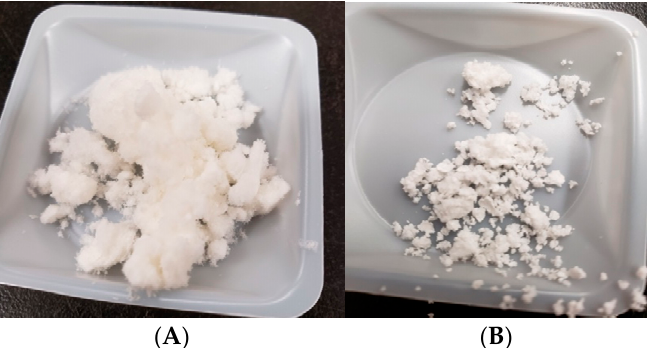
Figure 7. ( A ) Kdo 2 -Lipid A after lyophilization; ( B ) O-deacylated Kdo 2 -Lipid A after lyophilization.